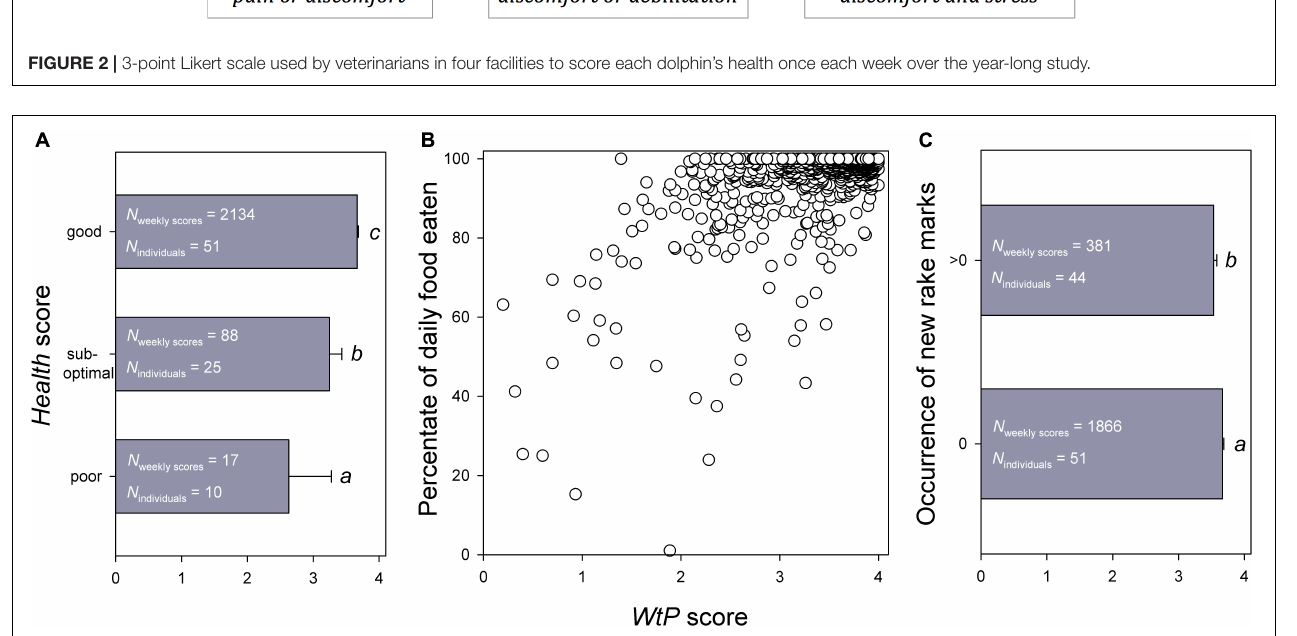
FIGURE 3 | Associations of the average weekly WtP score (reflecting the dolphin’s willingness to participate in Positive Reinforcement Training) with (A) the Health score assigned by the veterinarian during weekly visits, (B) the percentage of daily food eaten, and (C) the occurrence of new rake marks on the dolphin. All associations were statistically significant, see text for details. Different letters beneath the vertical bars in (A,C) highlight significant differences between categories within each